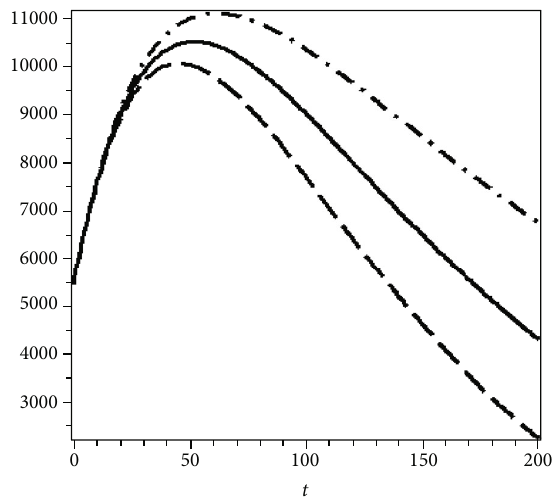
Figure 11: The e ff ect of vaccination on the suspected individuals (dashed line, v = 100000 , continuous line v = 75000 , and dashed- dotted line, v = 50000 ) for β 0 = 4 : 10 − 7 .